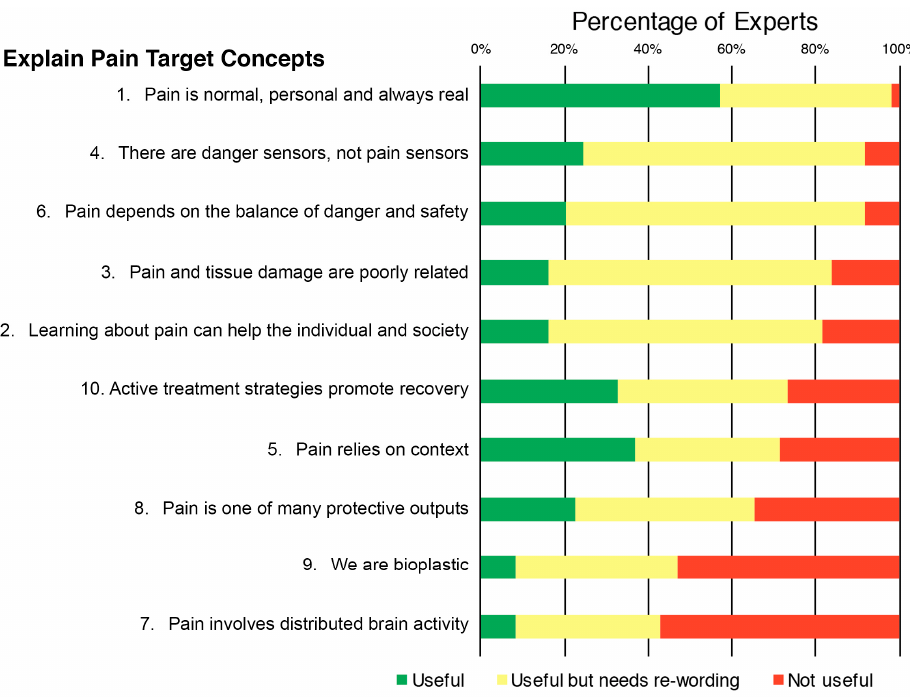
Figure 3. Distribution of pediatric pain experts’ ratings of the usefulness of the content of each item from the Explain Pain Target Concepts, and the need for rewording, in assessing a child’s concept of pain in children aged 8–12 years.